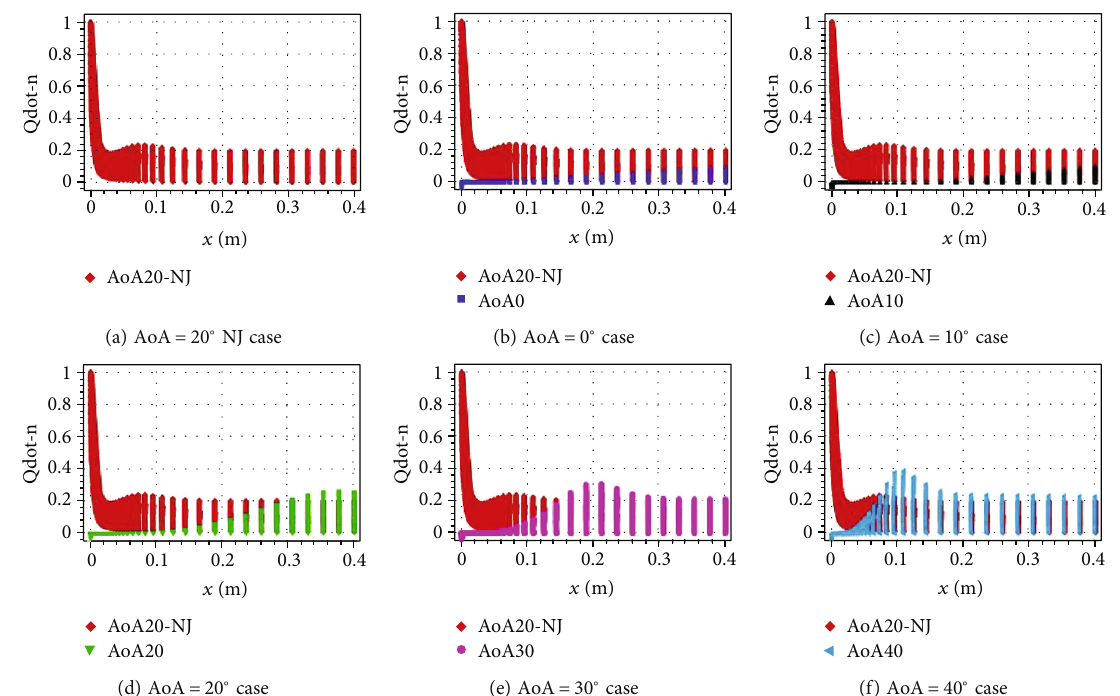
Figure 19: _ QN values of the NJ and J cases for di ff erent AoAs of the H70Ma20 series.